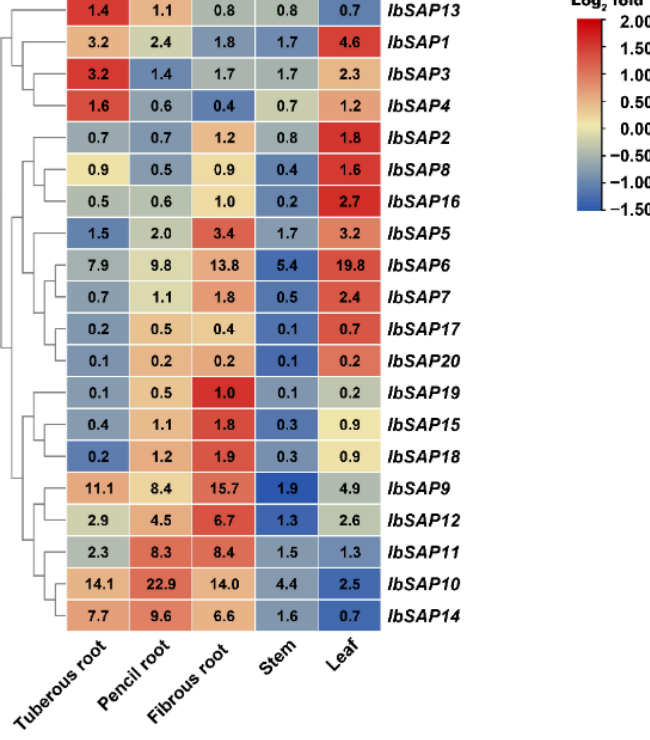
Figure 4. Expression profiles of IbSAP genes in different sweetpotato organs. The expression levels of IbSAPs were determined by RT-qPCR and quantified using the 2 − ∆∆ Ct method. I. batatas ADP- ribosylation factor ( IbARF , JX177359) was used as an internal reference. The mRNA level of IbSAP16 in fibrous roots was set as 1 and used to normalize the expression levels of other IbSAP genes. Organ-specific expression patterns of SAPs in the two diploid relatives of sweetpotato were also analyzed using the RNA-seq results of root 1, root 2, stem, leaf, flower, and flower bud of I. triloba and I. trifida [30]. The Itb/ItfSAPs were divided into two groups according to their organ-specific expression patterns (Figure 5). The first group included Itb/ItfSAPs highly expressed in roots. In I. triloba , the first group included ItbSAP1 , 6–12 , and 14–16 ; while in I. trifida , the first group included ItfSAP1, 4 , 6 , 7 , 9–12 , 14–16 , and 18 . The second group included Itb/ItfSAPs highly expressed in aerial parts (i.e., stem, leaf, flower, or flower bud) or were not expressed in the organs examined. ItbSAP4 , ItbSAP21 , and ItfSAP21 had the highest expression level in stems while ItbSAP21 and ItfSAP21 were only detected in stems. Two ItbSAPs ( ItbSAP17 and 20 ) and four ItfSAPs ( ItfSAP8 , 17 , 19 , and 20 ) had highest expression levels in flower buds, while five ItbSAP4s (i.e., ItbSAP2 , 3 , 5 , 13 , and 19 ) and four ItfSAPs ( ItfSAP2 , 3 , 5 , and 13 ) had the highest expression levels in flowers. Here, ItbSAP8 (expressed more in root than in leaf) and ItfSAP8 (expressed more in leaf than in root) had different expression patterns, and the expression pattern of ItfSAP8 was more similar to that of IbSAP8 , showing highest expression levels in leaves (Figure 4). In addition, three ItbSAPs ( ItbSAP7L , 18 , and 22 ) and five ItfSAPs ( ItfSAP3 , 7 , 9L1 , and 9L2 ) were not detected in any organs